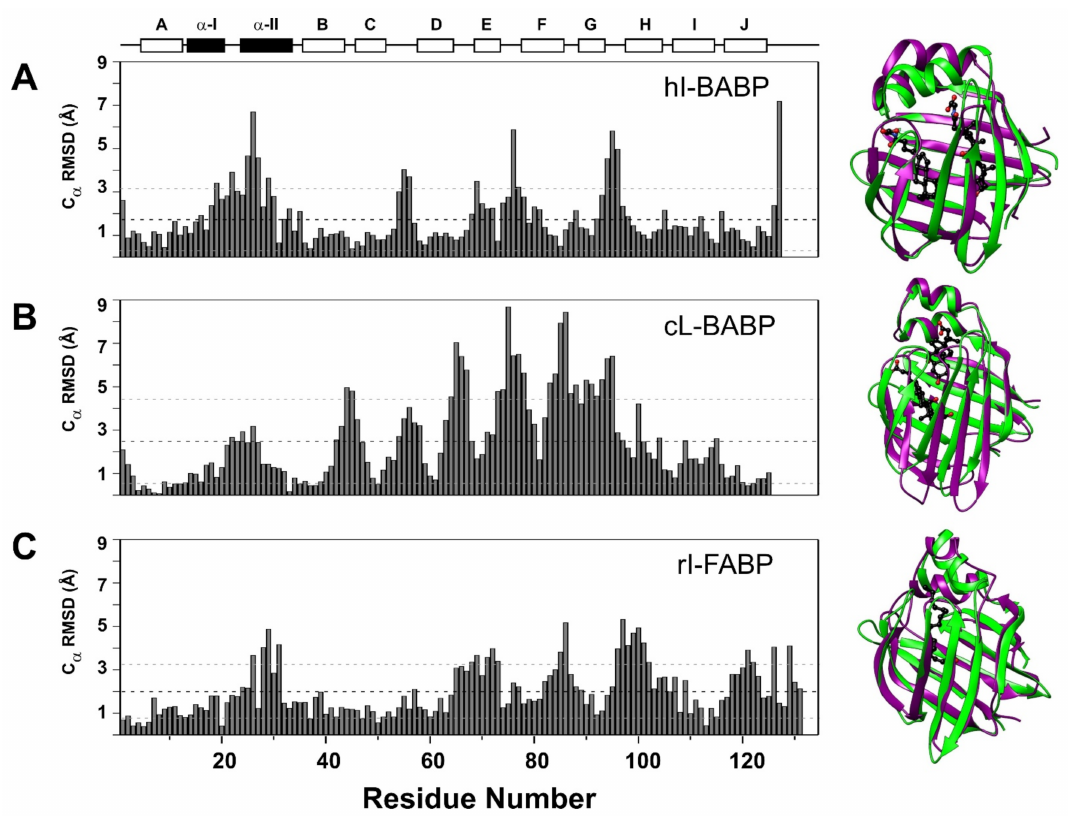
Figure 3. Backbone conformational change upon ligand binding. Displacement calculated for the C α trace between ( A ) the apo (PDB: 1o1u [39]) and the heterotypic doubly ligated (hI-BABP:GCA:GCDA, PDB: 2mm3 [25]) forms of human ileal BABP, ( B ) the apo (PDB: 1zry [56]) and the homotypic doubly ligated (cL-BABP:CDA:CDA, PDB: 2jn3 [40]) forms of chicken liver BABP, and ( C ) the apo (PDB: 1ael [63]) and holo (PDB: 1ure [59]) forms of rat intestinal FABP. Secondary structure elements are indicated at the top. Superimposed ribbon diagrams of the corresponding structures are shown on the right with the apo and holo forms in magenta and green, respectively. Bound ligands are in black, with oxygen atoms shown in